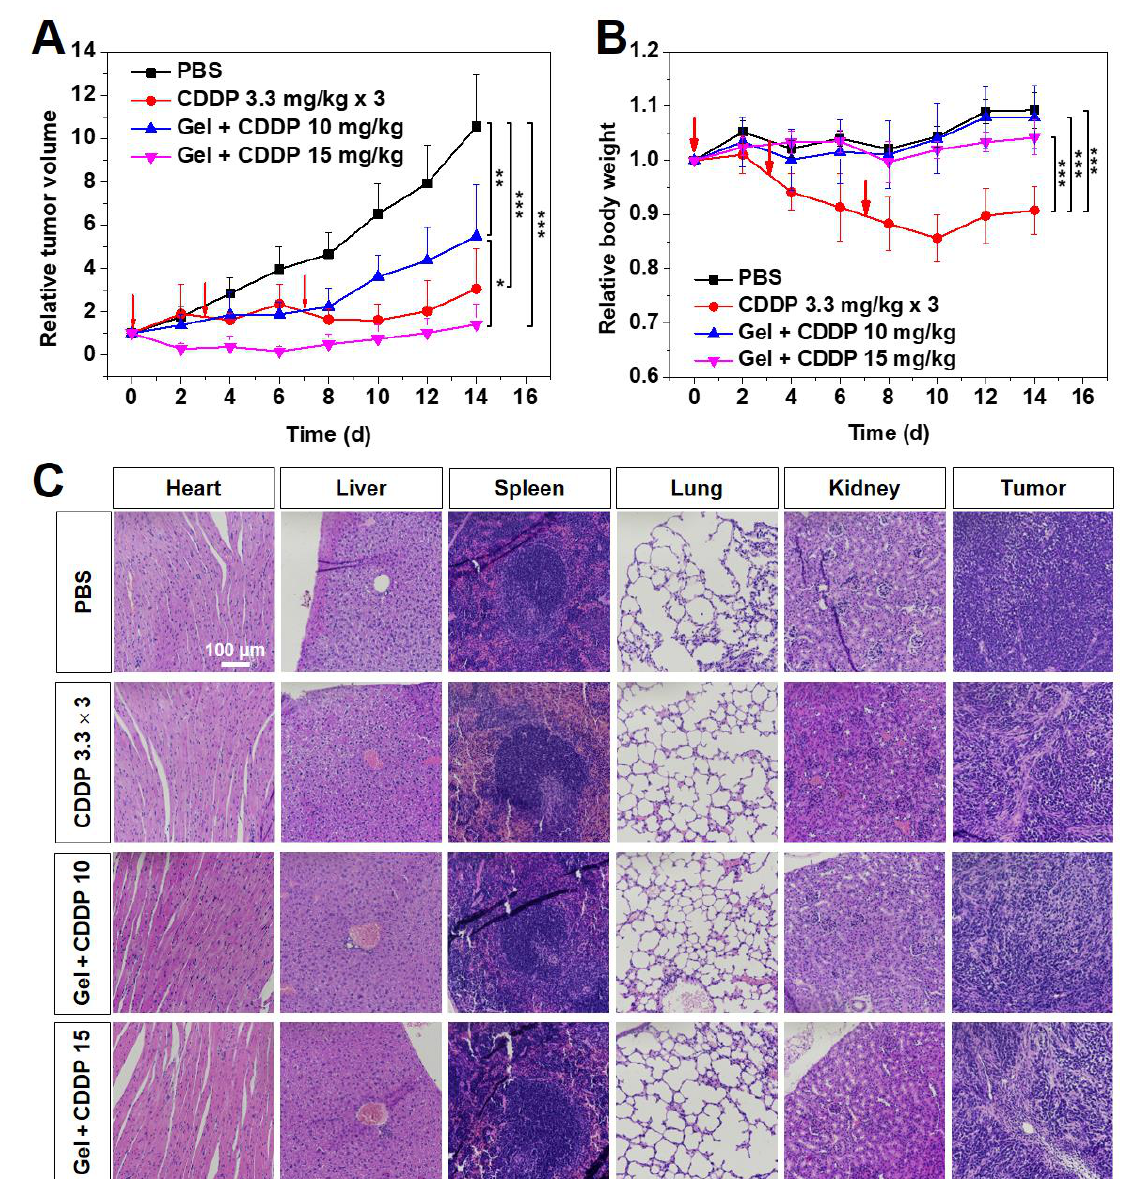
Figure 6. In vivo antitumor efficacy of CDDP-loaded hydrogels for treatment of BALB/c nude mice bearing MCF-7 xenografts. ( A ) Relative tumor volume. ( B ) Relative body weight. The arrows indicate 3 injections of free CDDP at each dose of 3.3 mg/kg on days 0, 3, 7. Data depict mean ± SD; values were analyzed by one-way ANOVA, * p < 0.05, ** p < 0.01, *** p < 0.001. ( C ) H&E staining of the tumor tissues and main organs of mice at day 14.